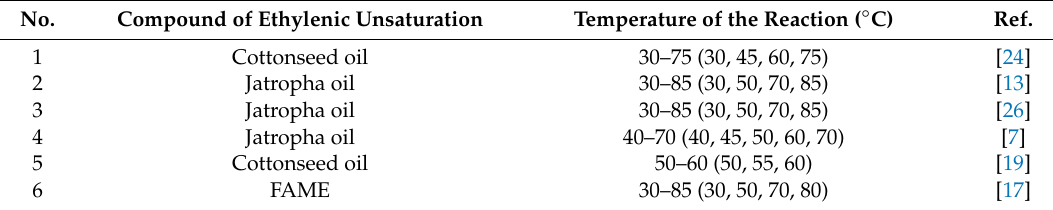
Table 4. Temperature of